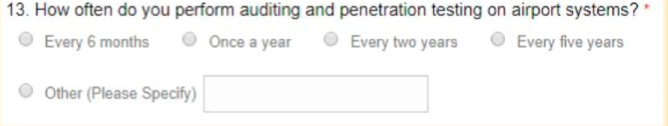
Figure A7. Question No. 12.